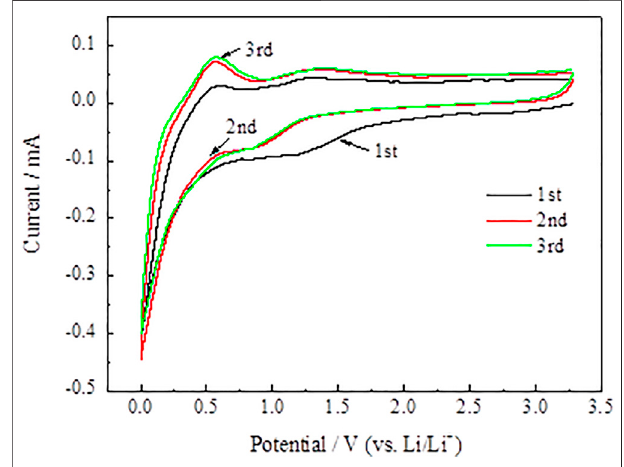
FIGURE 10 | Rate capability of SnO 2 @C and SnO 2 @C/graphene.